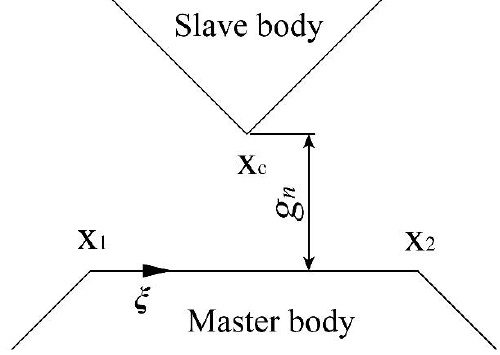
Figure 1. Contact of two bodies.